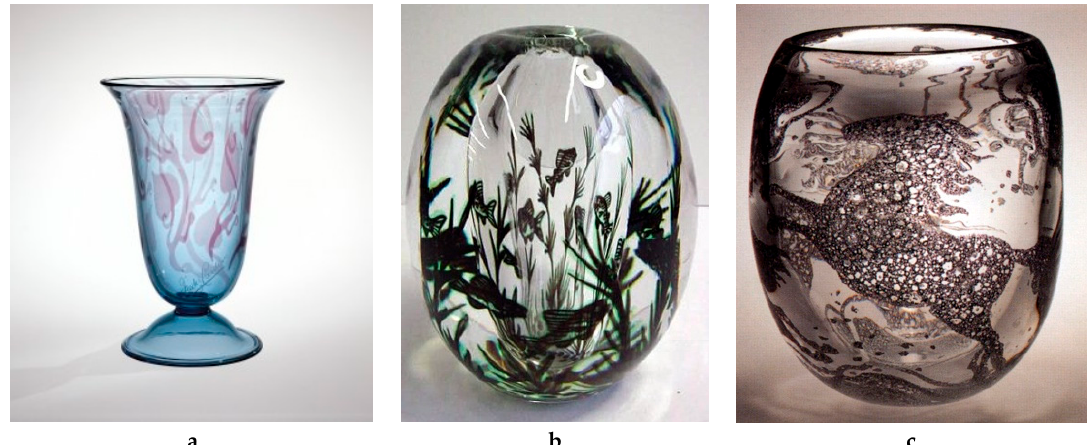
Figure 2. ( a ) ‘ Intarsia ’ vase (1920–1929), made by Steuben Division and Johnny Jansson in the Corning Glassworks, USA. Height 174 mm. The Corning Museum of Glass collection. ( b ) ‘ Graal ’ fish vase (unknown), made by Hald, Edvard Niels Tove (1883–1980) in Orrefors Glasbruk, Sweden. Height 132 mm. The Corning Museum of Glass collection. ( c ) ‘ Horse ’- Mykene glass vase (1936), made by Vicke Lindstrand in Orrefors Glasbruk, Sweden. Photographic source: from Ray Flavell’s PhD thesis (2001) (Flavell 2001). Used by permission.